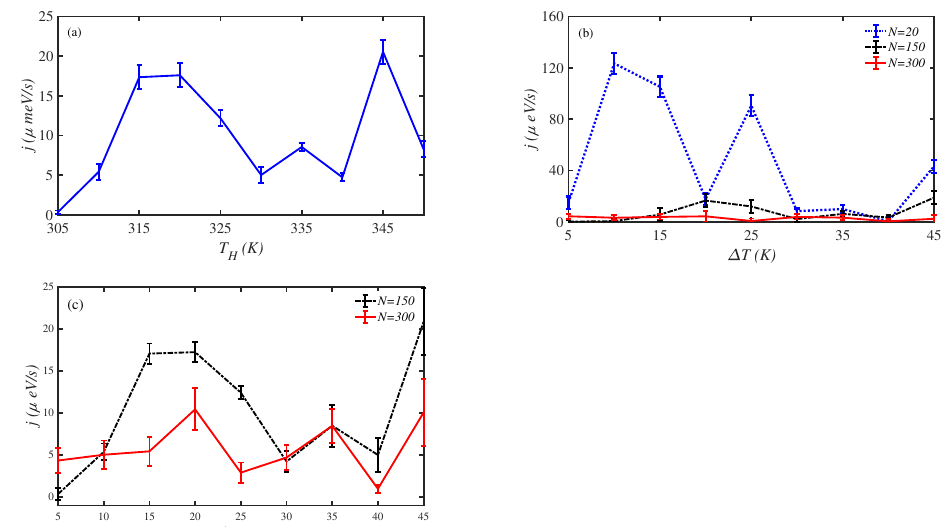
Figure 3. The energy transport rate, j , along a N = 150 site chain, ( a ) for different temperatures of hot source, T H , at a fixed temperature difference, ∆ T = 5 K, and ( b ) for different temperature differences, ∆ T , and the temperature of the cold source, T = 300 K. ( c ) The zoomed figure of the energy transport C rate, j , along the N = 150 and N = 300 site chains for different temperature differences, ∆ T